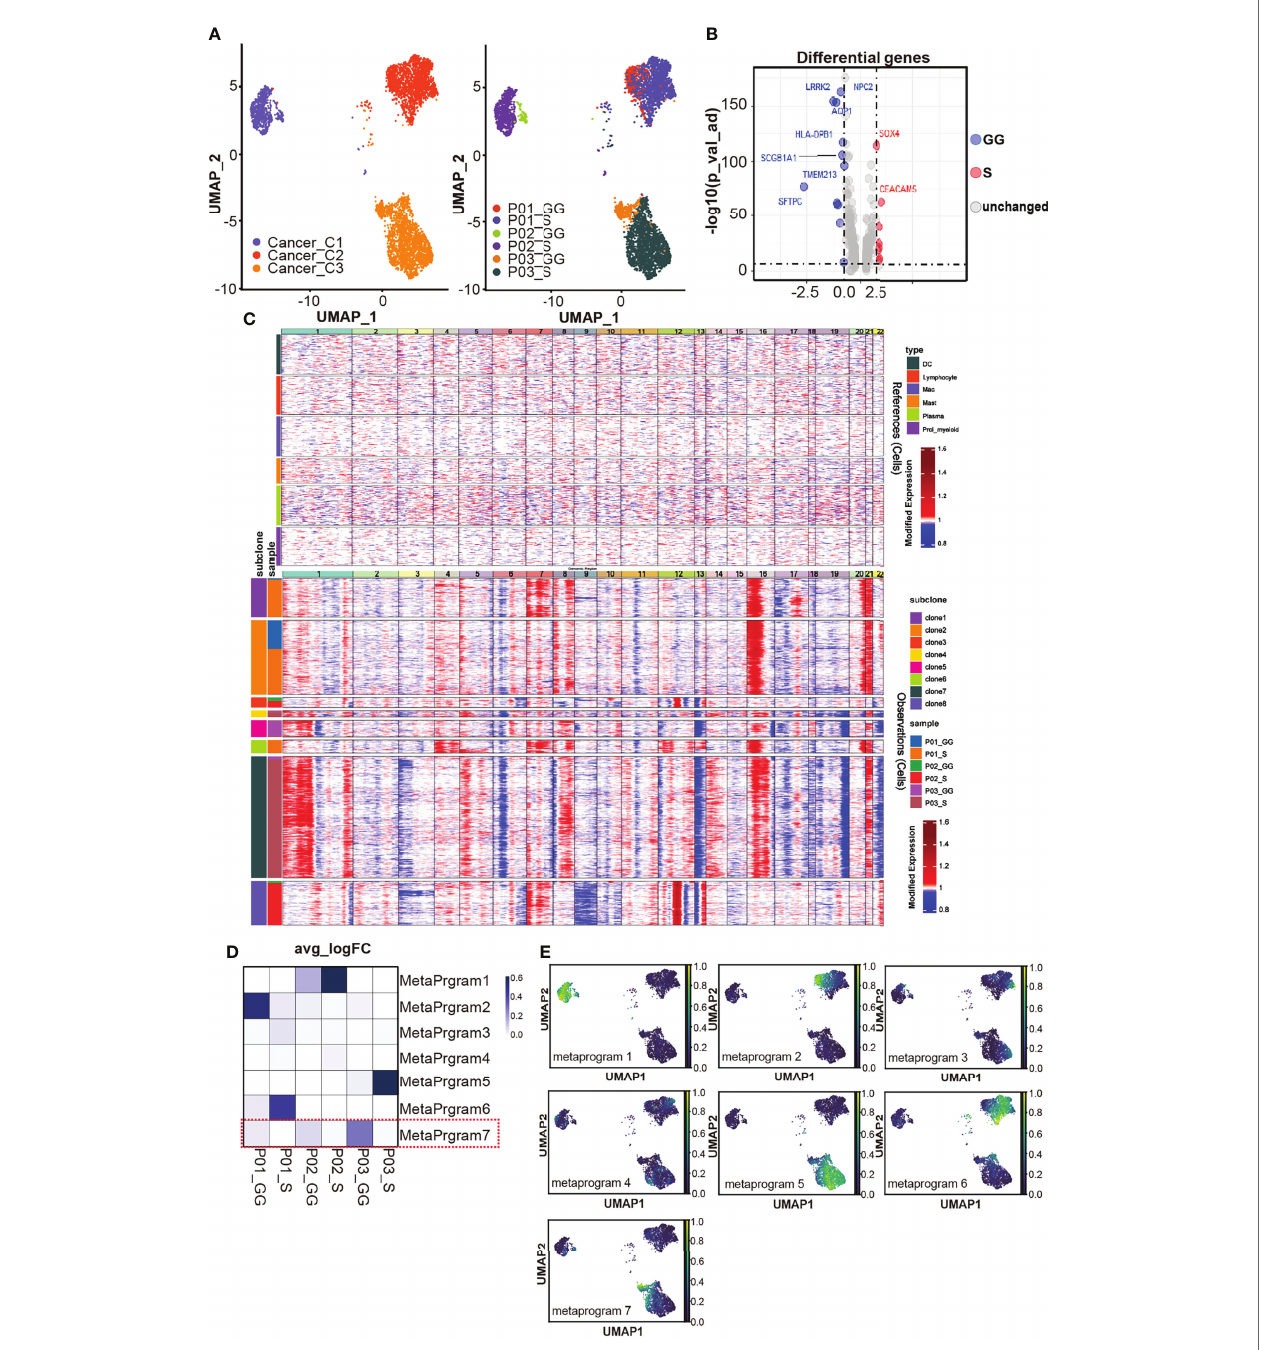
FIGURE 2 | Distinct transcriptome signatures of cancer cells in different components. (A) The UMAP visualization of cancer cells: the left graph shows that they are clustered into three subclusters, and the right graph labels these cells by sample sources. (B) The volcano plot reveals differentially expressed genes in S component and GG component. Threshold has been set as 10 − 5 for p_val_adj and 0.75 for avg_logFC. (C) Hierarchical clustering of the chromosomal gene expression pattern separating cancer cells from non-malignant immune cell clusters. Each row represents a sample, and each column represents a single cell. (D) The UMAP visualization shows the expression level of gene sets within each meta-program clustered by the cNMF in cancer cell clusters. (E) The heatmap shows the expression level of gene sets within each meta-program (row) by sample (column). The red box marks GG component-speci fi c meta-program. UMAP, Uniform Manifold Approximation and Projection; S, solid; GG, ground glass; cNMF, coupled non-negative matrix